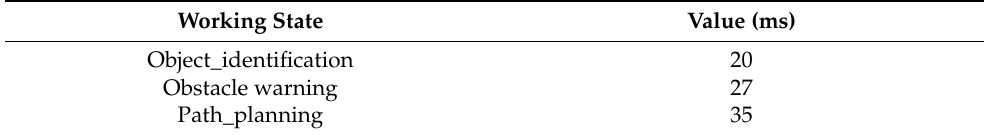
Table 3. The delay time of target analysis